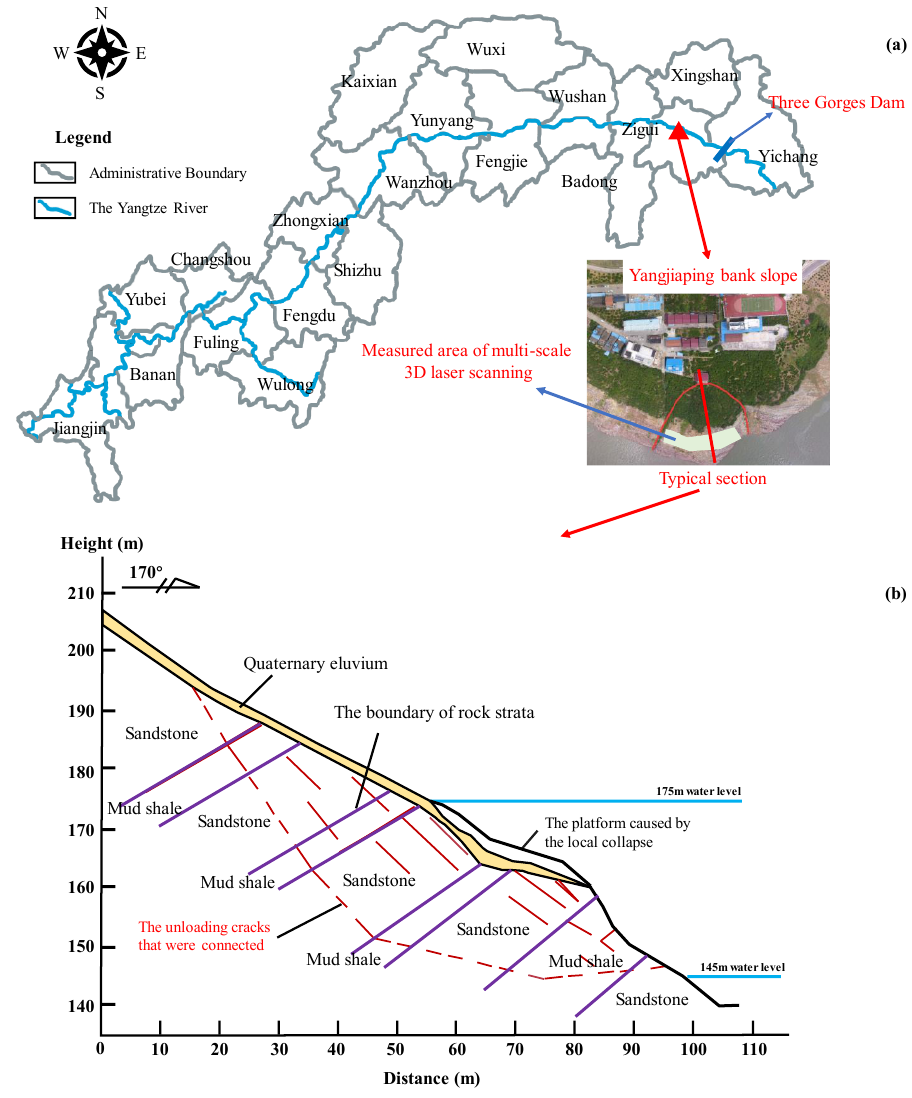
Figure 2. The ( a ) location, and ( b ) typical section of the Yangjiaping bank slope.